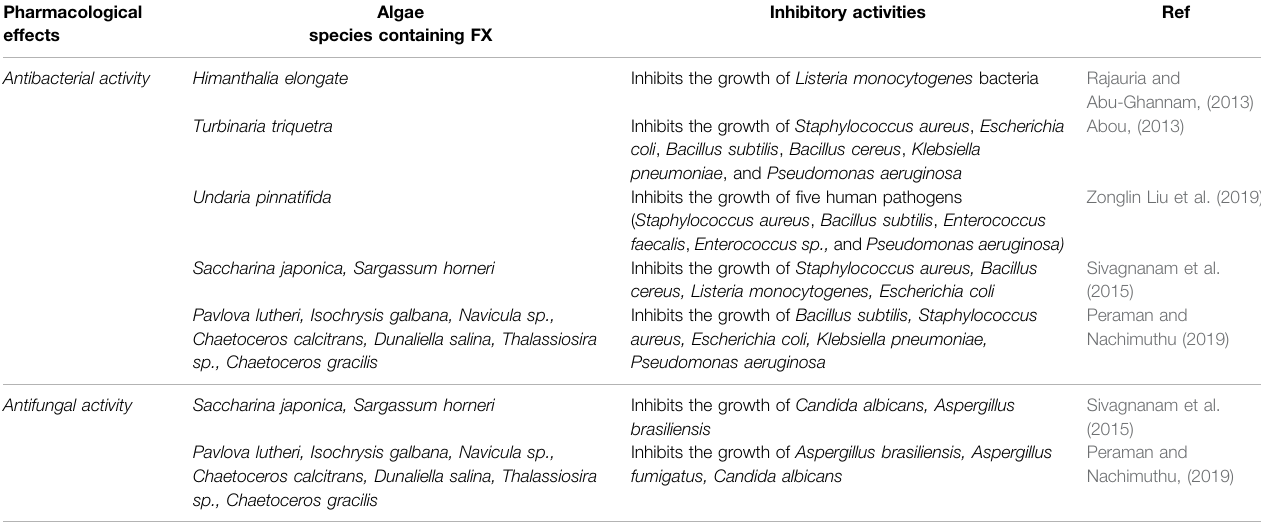
TABLE 2 | Antibacterial and antifungal activities of FX-containing